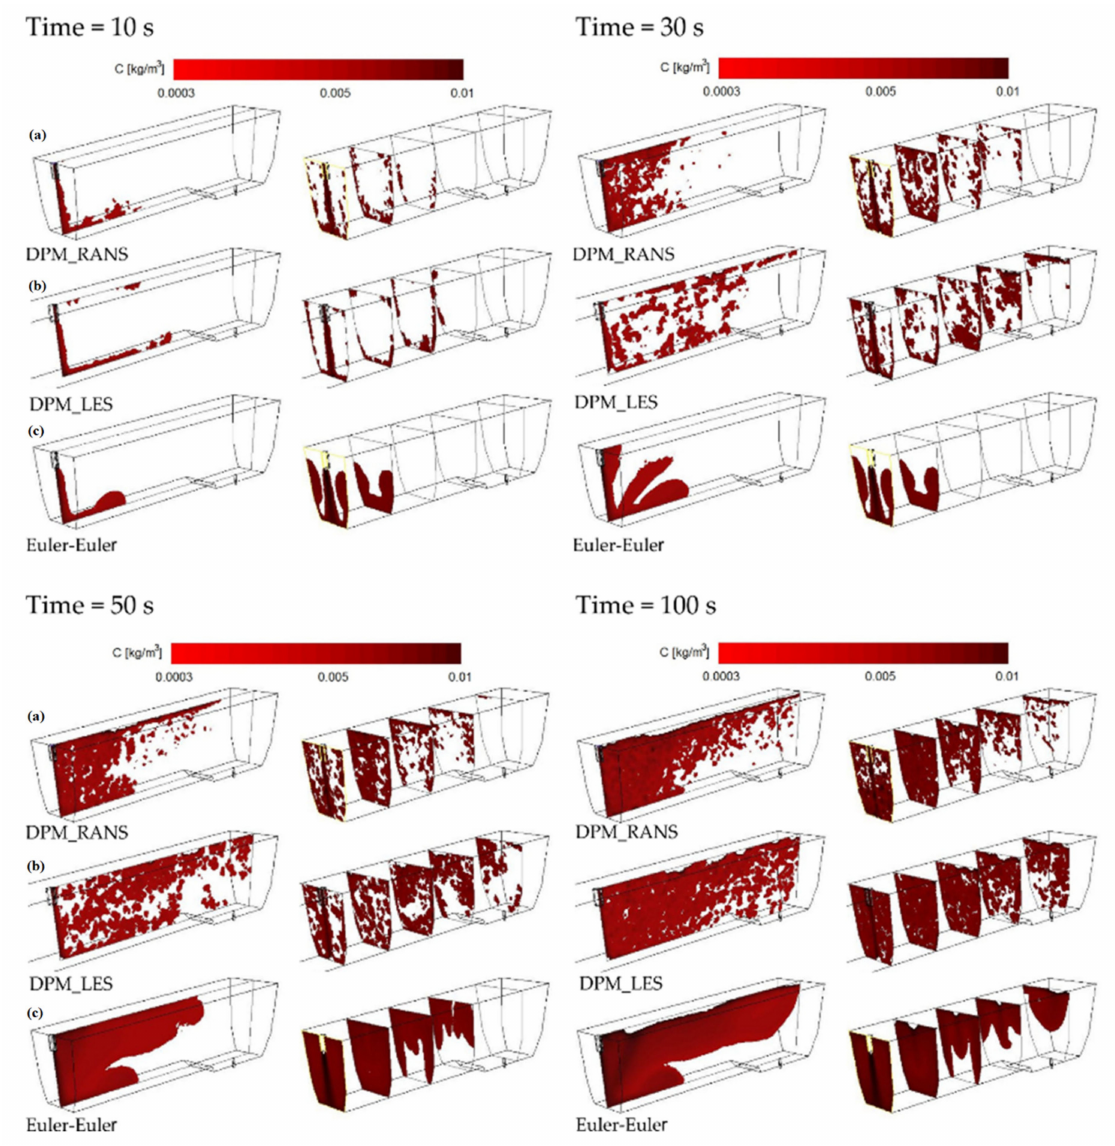
Figure 5. Contour maps of microparticles distribution (50 µ m) on the control planes: ( a ) DPM_RANS; ( b ) DPM_LES; ( c )